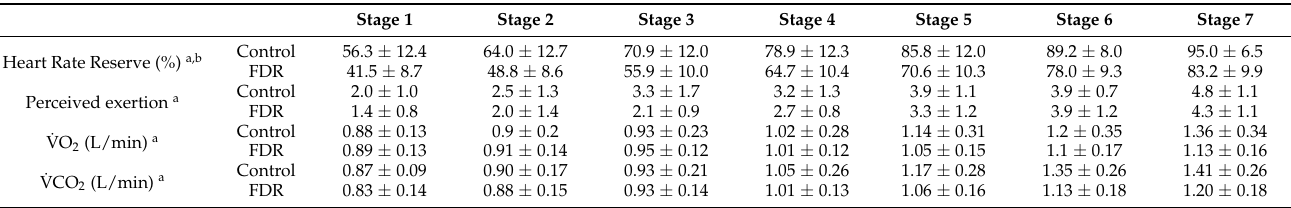
Table 3. Submaximal exercise